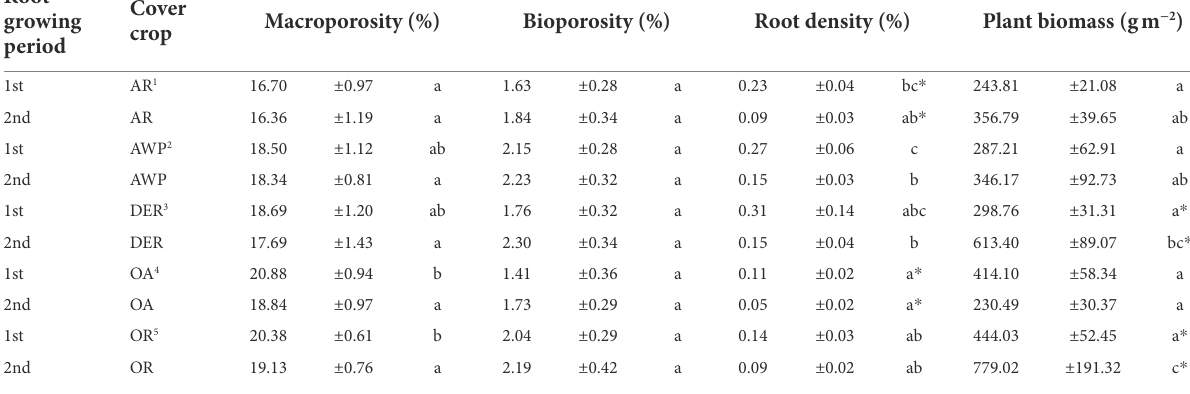
TABLE 1 Distribution of pores, biopores and roots in cores of the five studied cover crop species. Root growing